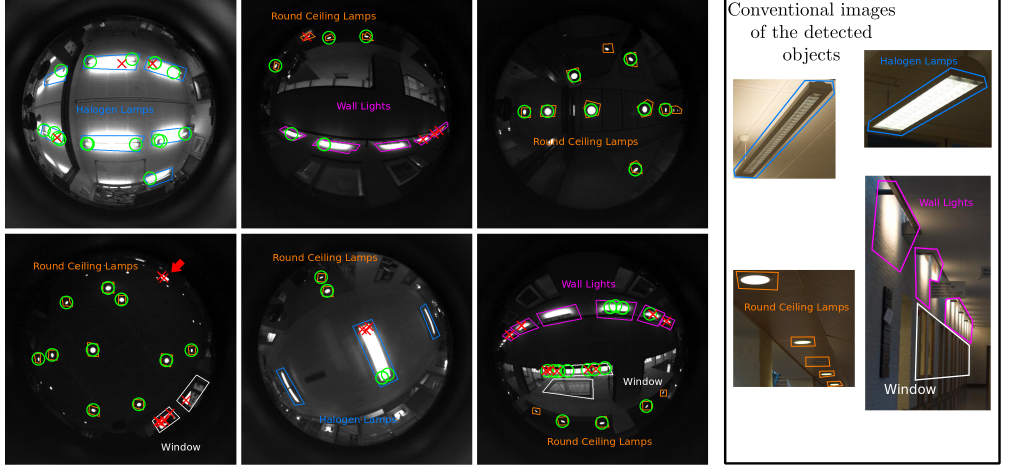
Figure 3. Examples of objects discovered in the data-set. Green circles mark correct assignments and red crosses show incorrect ones. The colored shapes show the labeled areas: round Ceiling Lamps ( orange ); Halogen lamps ( blue ); wall Lights ( magenta ); windows ( white ). Matching threshold is set to 0.15. For clarity, some conventional images of the objects in the environment are shown on the right of the figure. (Best seen in